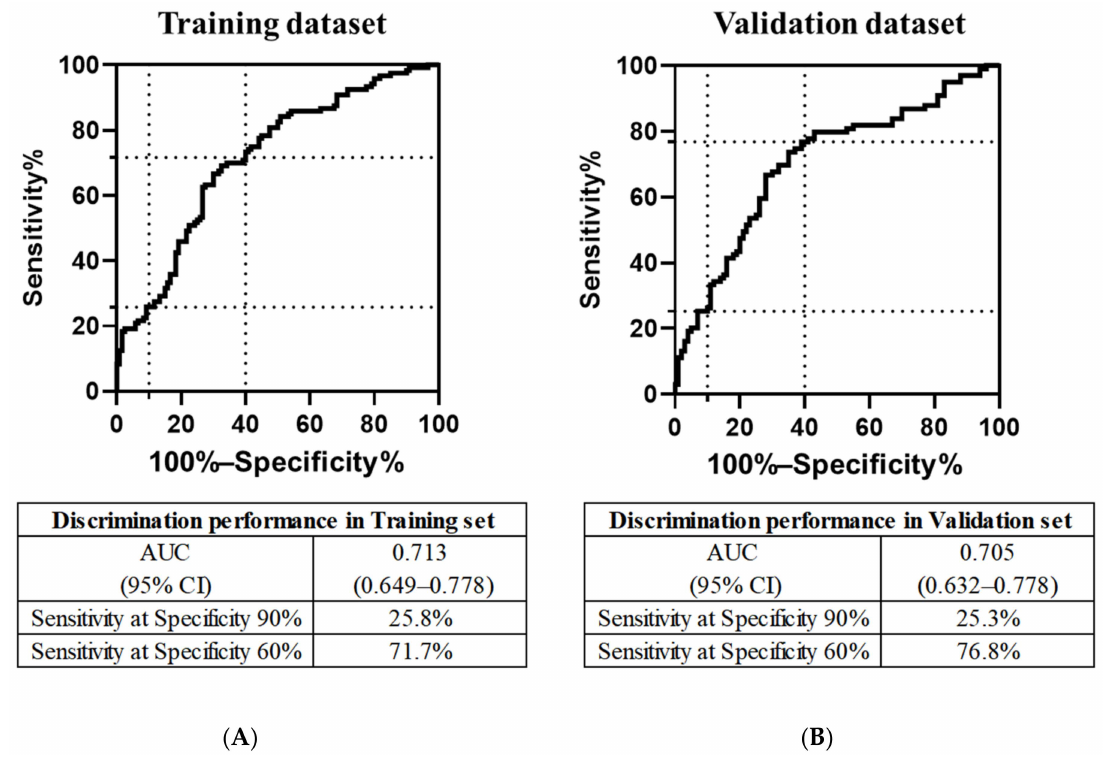
Figure 3. ROC curves of the PFAA index 1 . ( A ) ROC curves of the PFAA index for MCI participants compared with CN participants in the training dataset (120 MCI and matching 120 CN) and ( B ) the validation dataset (99 MCI and 100 remaining CN). The vertical dotted lines show specificities of 90% and 60%. The horizontal dotted lines show the sensitivities at specificities of 90% and 60%. 1 The PFAA index consists of the following variables: Alb, Ser, Thr, Cit, Lys, and